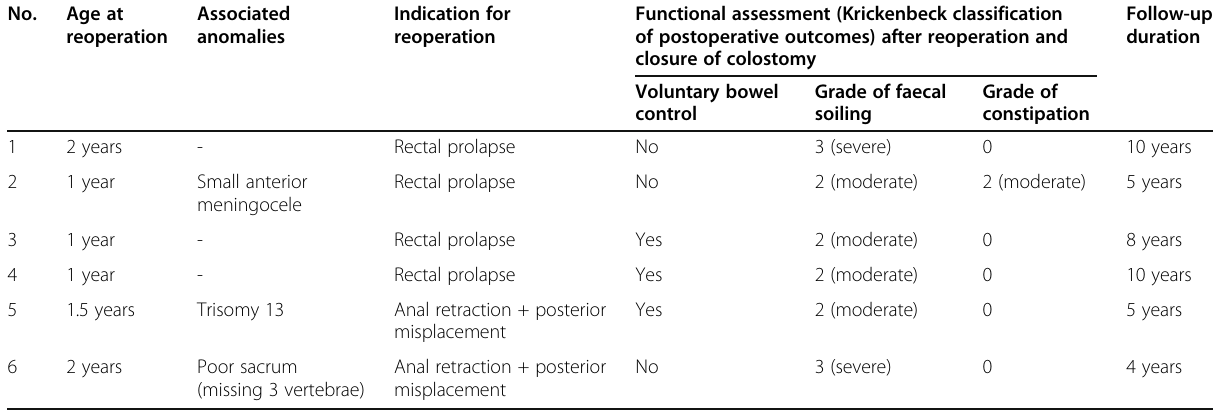
Table 2 The functional outcome after reoperation and closure of colostomy in group A No.